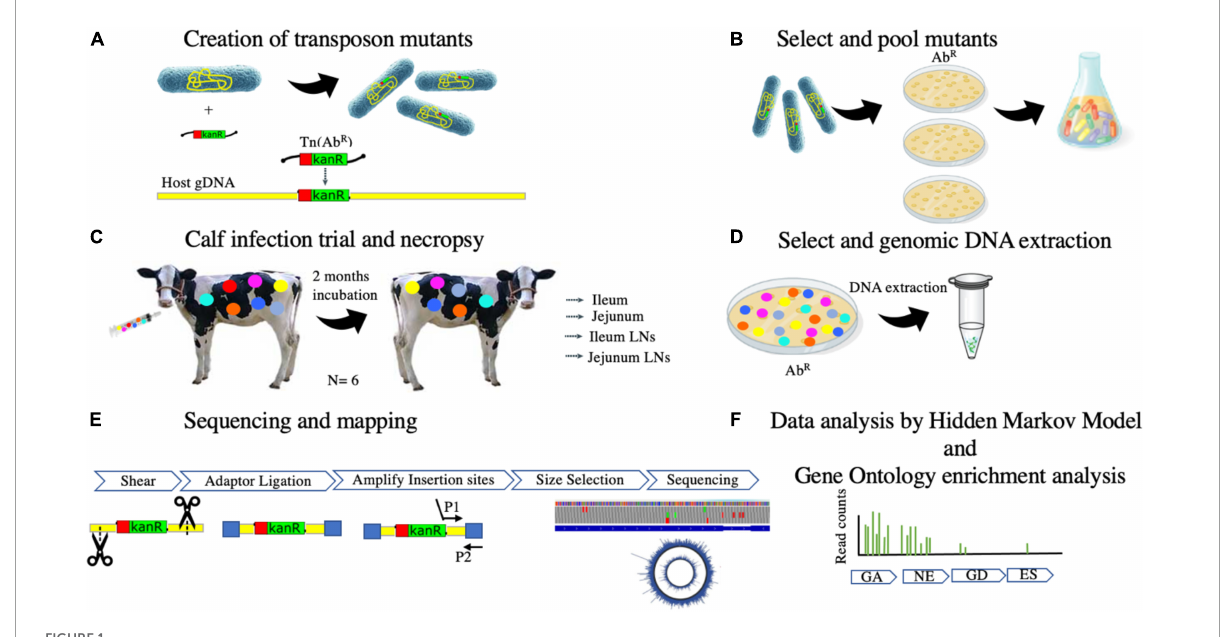
FIGURE1 (A–F) Overview of the experimental procedures to identify essential genes for MAP to persist in natural ruminant host by